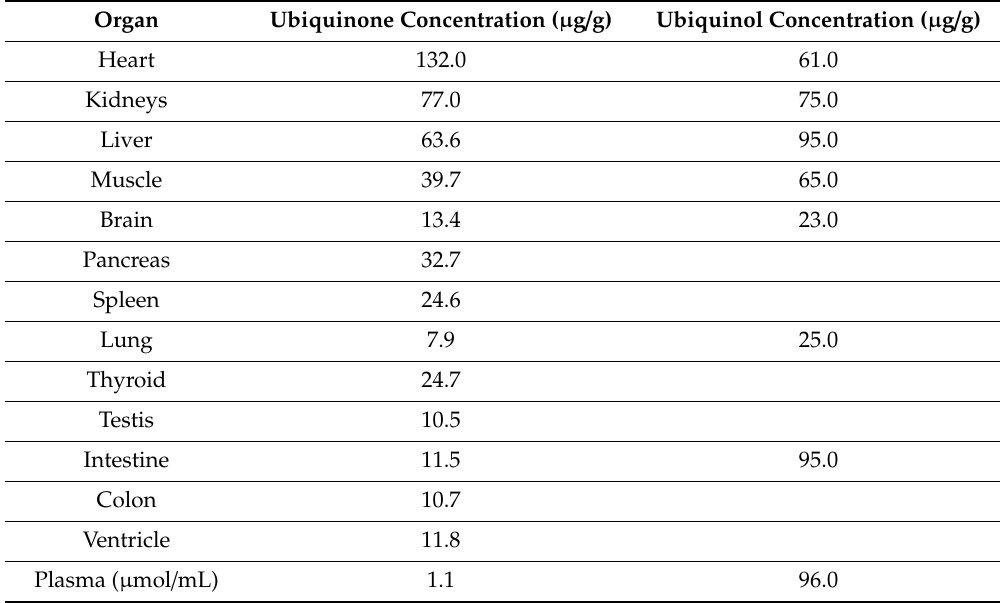
Figure 1. Chemical structure of CoQ 10 . Table 1. Distribution of ubiquinone and ubiquinol in human tissues (modified from References